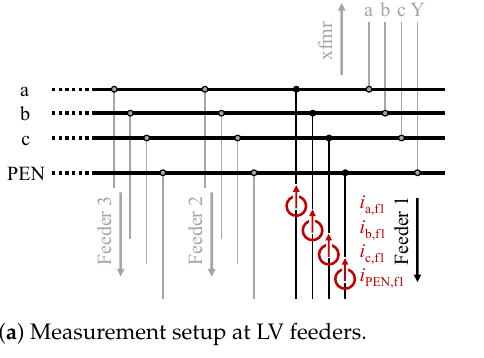
Figure 2. Measurement schemes ( xfmr: transformer